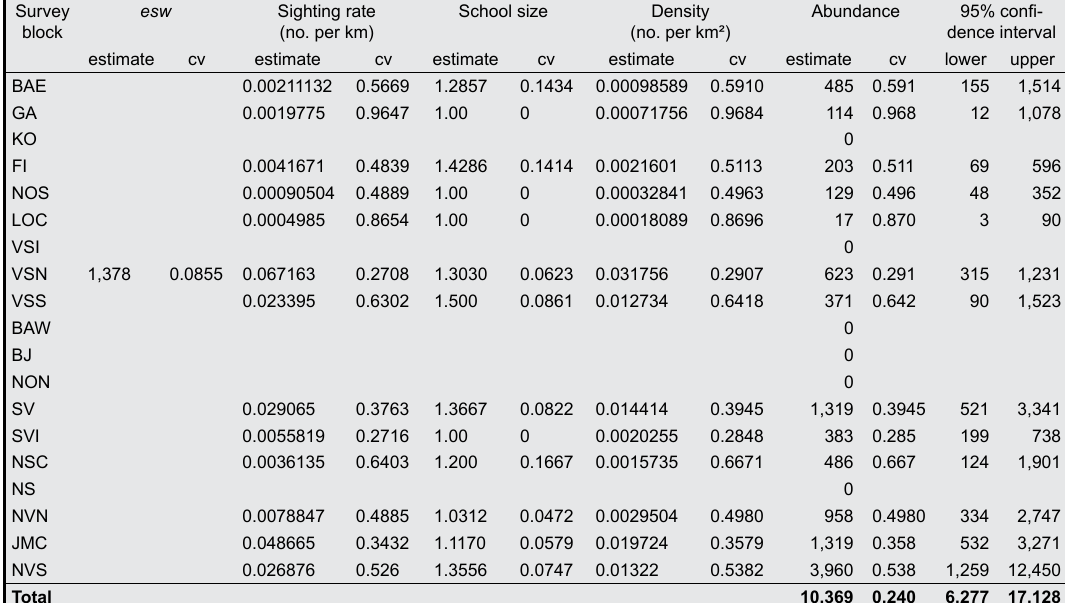
School size Density